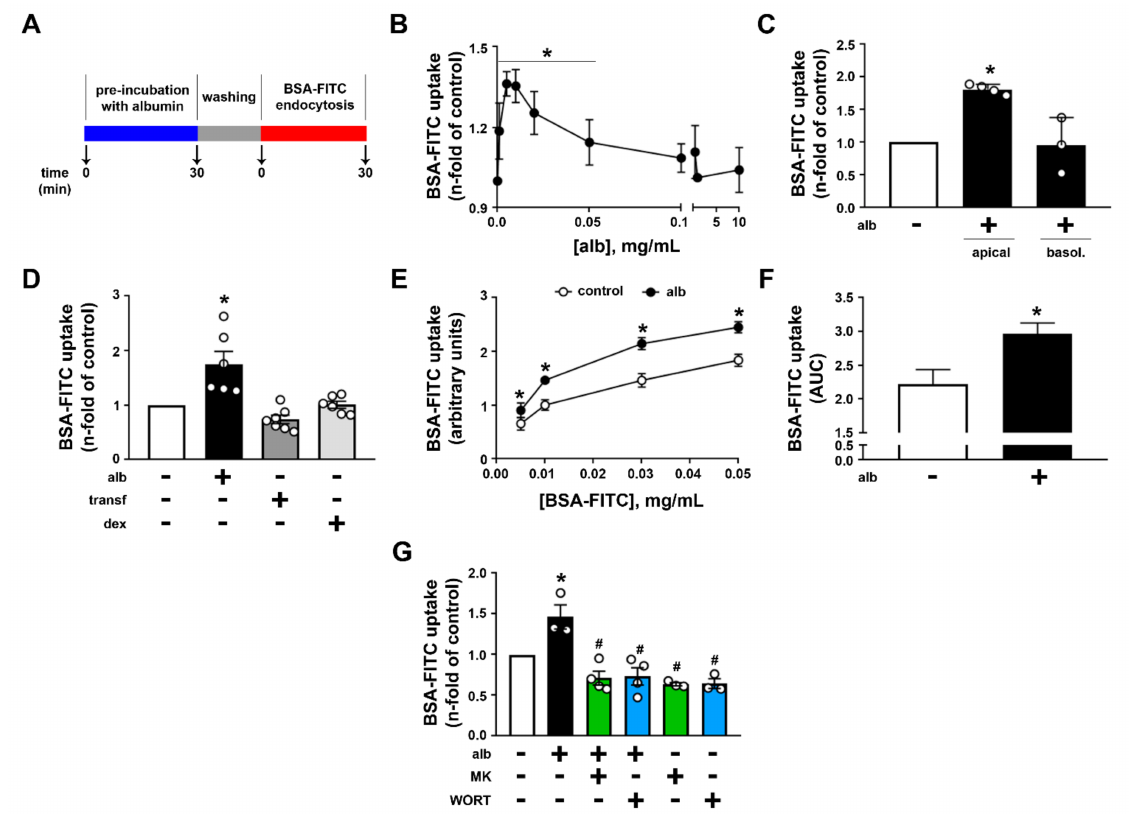
Figure 5. Albumin induces albumin endocytosis through activation of the PI3K/AKT pathway. ( A ) Scheme of the protocol used to study the effect of albumin on BSA-FITC uptake. Cells were pre-incubated with albumin, washed out, and BSA-FITC uptake was measured. ( B ) Dose–response curve of pre-treatment with albumin (alb) for 30 min on BSA-FITC uptake. Albumin concentrations range from 0.001 mg/mL to 10 mg/mL. The graphic represents the fold of control (in the absence of albumin). ( C ) Effect of 0.01 mg/mL albumin added on the apical or basolateral side of LLC-PK1 cells grown in Transwell plates (n = at least 3). ( D ) BSA-FITC uptake was analyzed in LLC-PK1 cells treated with mg/mL albumin, transferrin, or 60 kDa dextran for 30 min. All compounds were used at a concentration of 0.01 mg/mL. Results are expressed as fold of control. ( E ) Dose–response curve of BSA-FITC on BSA-FITC uptake was evaluated in LLC-PK1 cells pre-treated or not with 0.01 mg/mL albumin for 30 min. ( F ) Area under the curve (AUC) of BSA-FITC uptake obtained in ( E ). ( G ) BSA-FITC uptake in LLC-PK1 cells was analyzed after treatment with 0.01 mg/mL albumin for 30 min in the presence or in the absence of MK2206 (MK) and wortmannin (WORT). Data are presented as means ± standard deviation. * p < 0.05 versus control, # p < 0.05 versus albumin. One-way ANOVA with Tukey’s multiple comparisons test ( B – E , G ) or unpaired Student’s t test ( F ) was